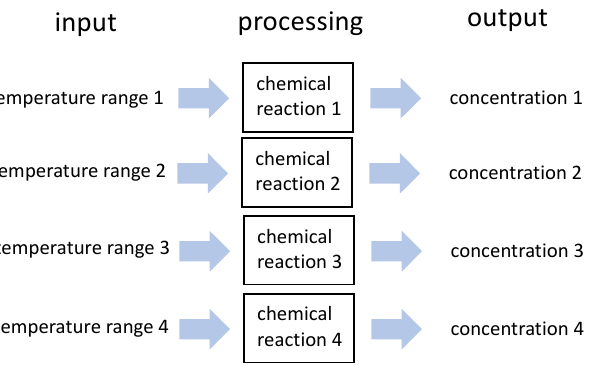
Figure 9. Parallel processing to cover broad temperature ranges employing different thermal in- put/concentration output systems processed by chemical reactions.